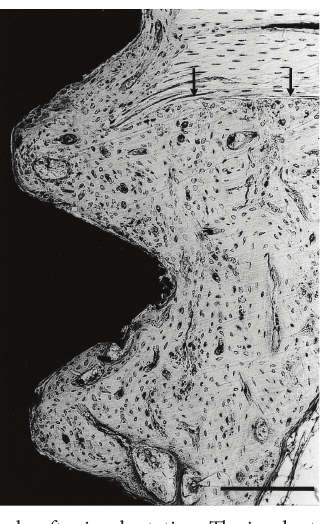
Figure 7: Six weeks after implantation. The implant surface towards the marrow cavity was in general in continuity with the cortical bone. Close bone-implant contact was seen for all implant types, and the threads were filled with woven bone. H 2 O 2 treated implant. Bar = 200 𝜇